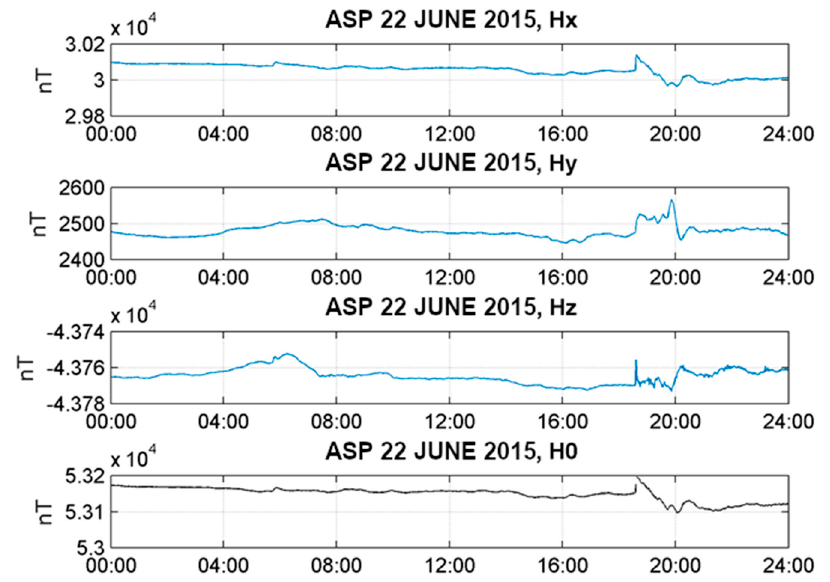
Figure 1. Plots of one-minute-averaged data of the components 𝐻 (cid:3051) , 𝐻 (cid:3052) , 𝐻 (cid:3053) and the total intensity of the geomagnetic field strength vector with SC during 22 June 𝐻 (cid:2868) of the geomagnetic field strength vector with SC during 22 June 2015.